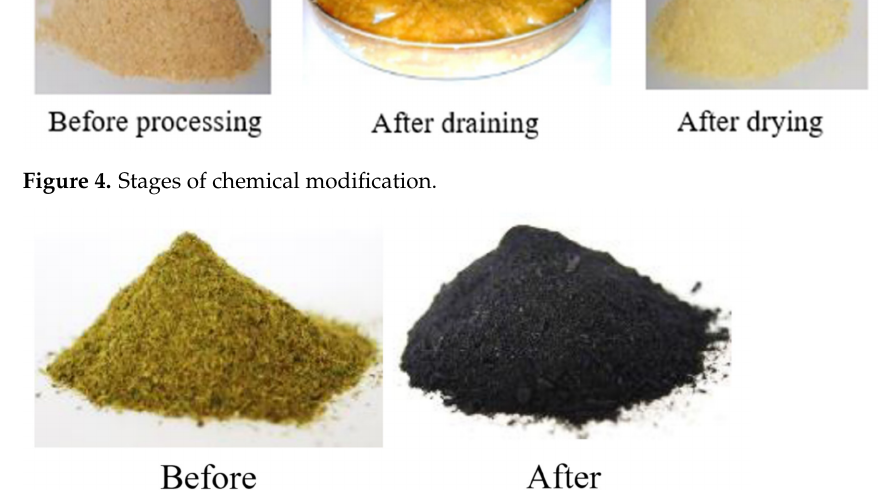
Figure 5. Material before and after